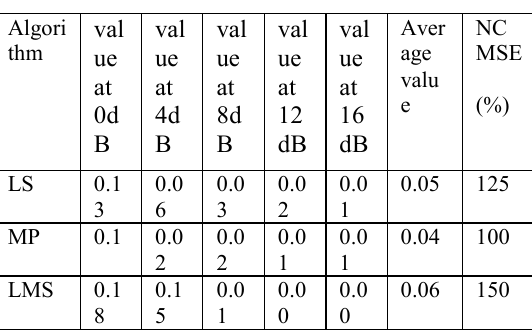
Figure 4: NCMSE VS SNR